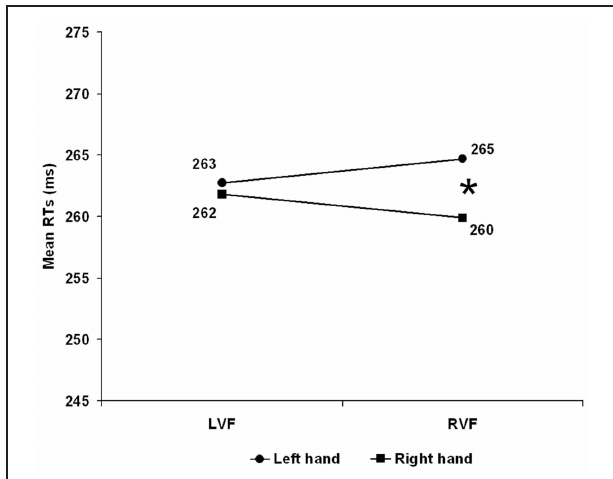
FIGURE 2 | Experiment 2: Left Handers. Mean reaction time (RT) as a function of visual hemifield of stimulus presentation and response hand. LVF, Left visual field; RVF, right visual